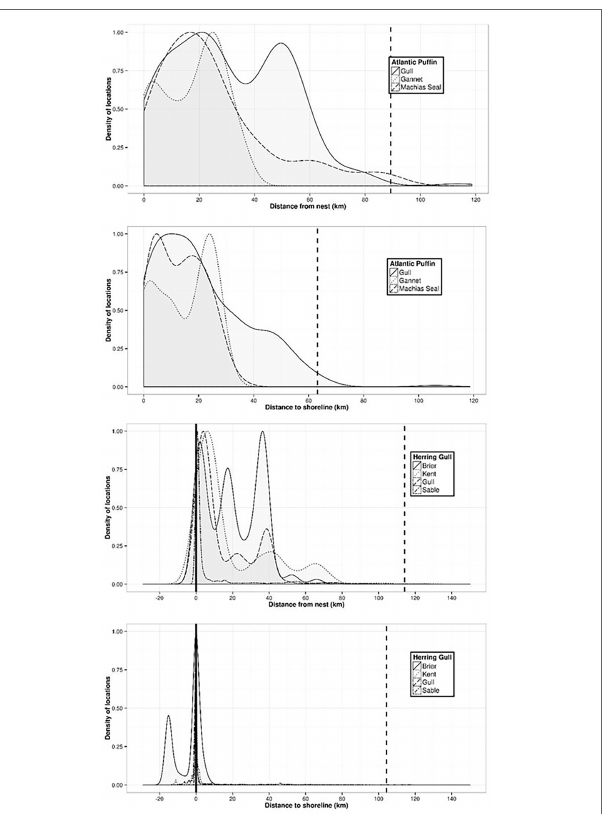
FIGURE 4 | Smoothed density estimates of telemetry locations with respect to distance from colony (i.e. nest site; upper panels) and distance to coastline (lower panels) for Atlantic puffin and herring gull (see Supplemental Materials Figure S1 for plots of other species). Density estimates are scaled from 0 to 1 for each study colony, where a density of 1 occurs at the distance where the highest density of locations occurs. Dashed vertical lines show 99th percentile of distance measurements ( Table 5 ).